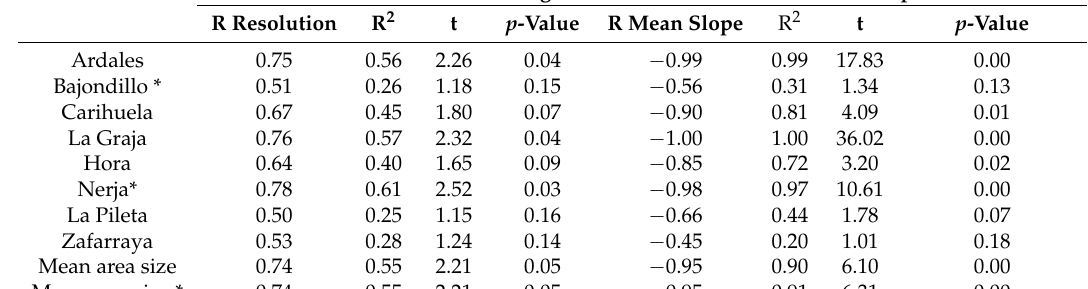
Correlation of Resulting Area Sizes with Different Properties of the Resampled 5-m